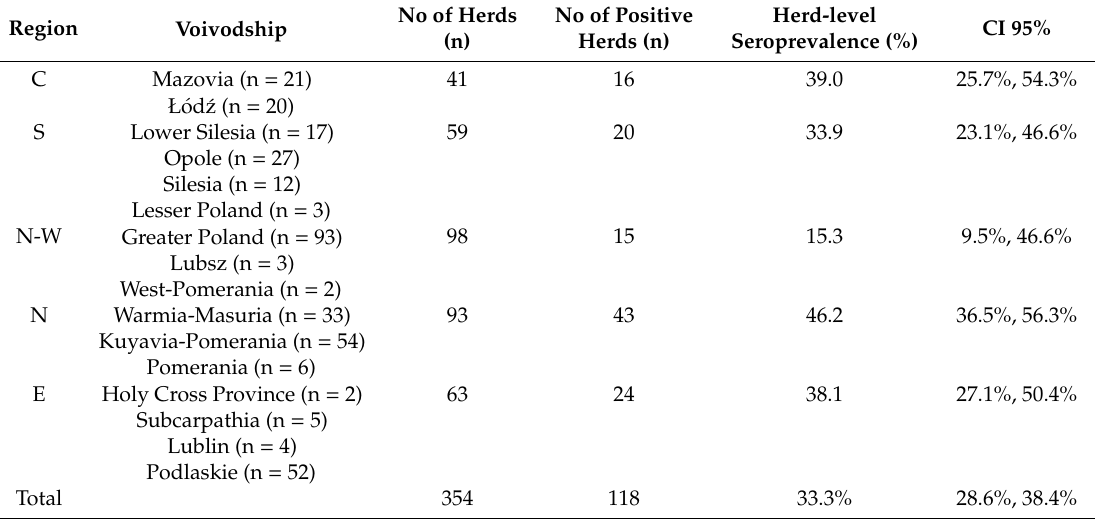
Table 2. Distribution of BVDV-positive herds in geographical regions of